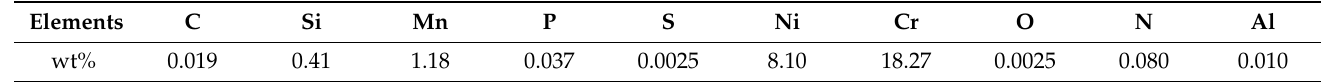
Table 1. Chemical composition of metal consumable electrode.